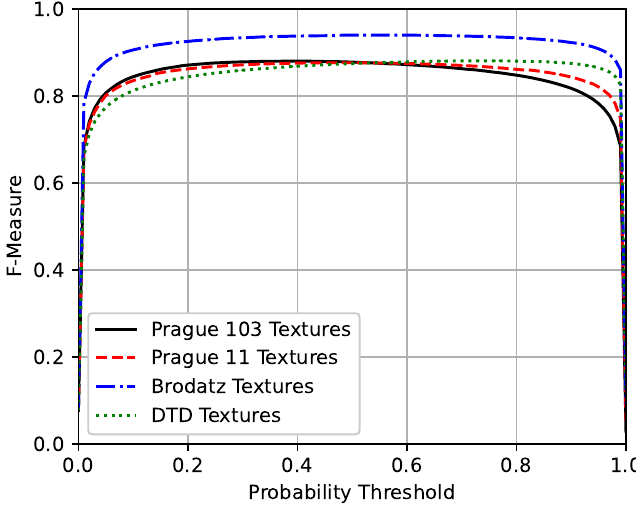
Figure 11. Precision–recall curves for the four different test sets.